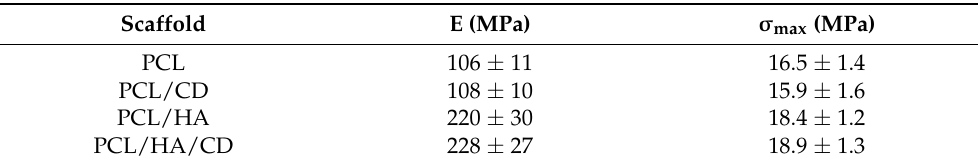
Figure 6. Representative stress-strain curves illustrating the mechanical response of PCL, PCL/CD, PCL/HA and PCL/HA/CD scaffolds (rate of 1 mm/min, final strain of 50%). Table 7. Mechanical properties of PCL, PCL/CD, PCL/HA and PCL/HA/CD scaffolds: compressive modulus (E) and maximum stress ( σ max